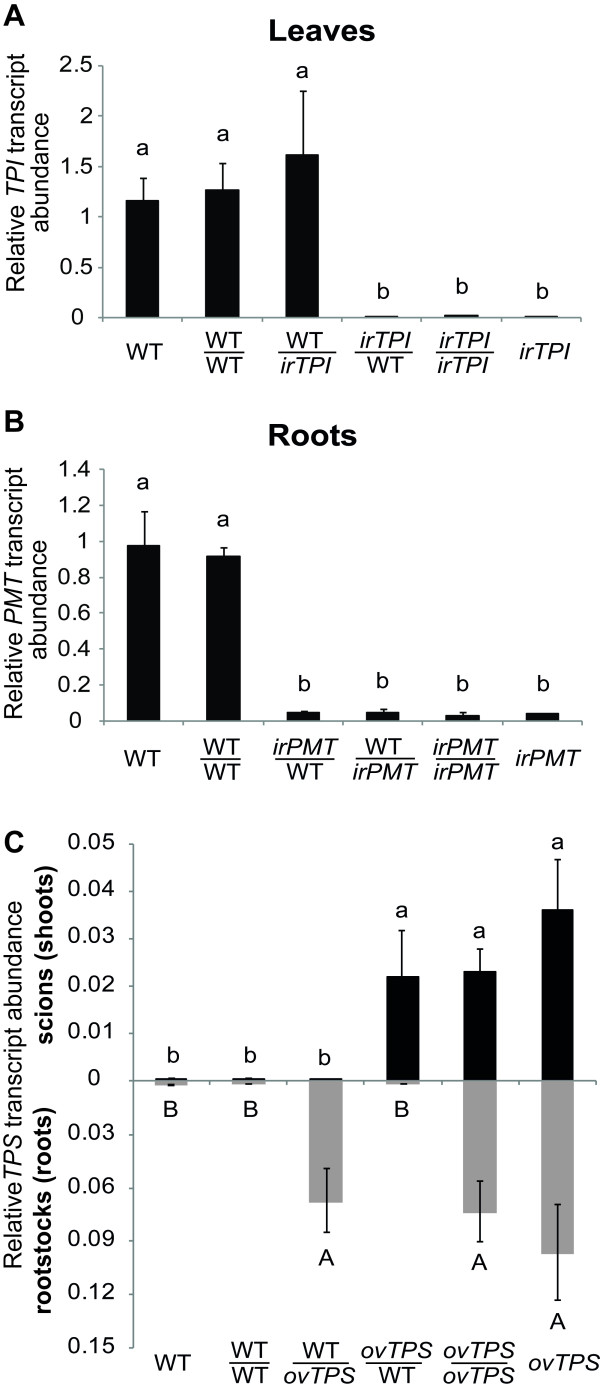
Molecular analysis of leaves and roots of grafted plants transformed with different RNAi and overexpression constructs. (A) TPI (normally expressed only in scions) transcript levels of leaves (scions) of intact or grafted WT and irTPI-silenced plants. (B) PMT (normally expressed only in roots) transcript levels of roots (rootstocks) of intact or grafted WT and irPMT-silenced plants. (C) TPS transcript levels of leaves (scions) and roots (rootstocks) of intact or grafted WT and ovTPS-overexpressing plants, in which a TPS from Z. mays was ectopically expressed behind a 35S promoter. Bars sharing same letters do not significantly differ (Kruskal-Wallis test followed by Fisher's PLSD, n = 5).